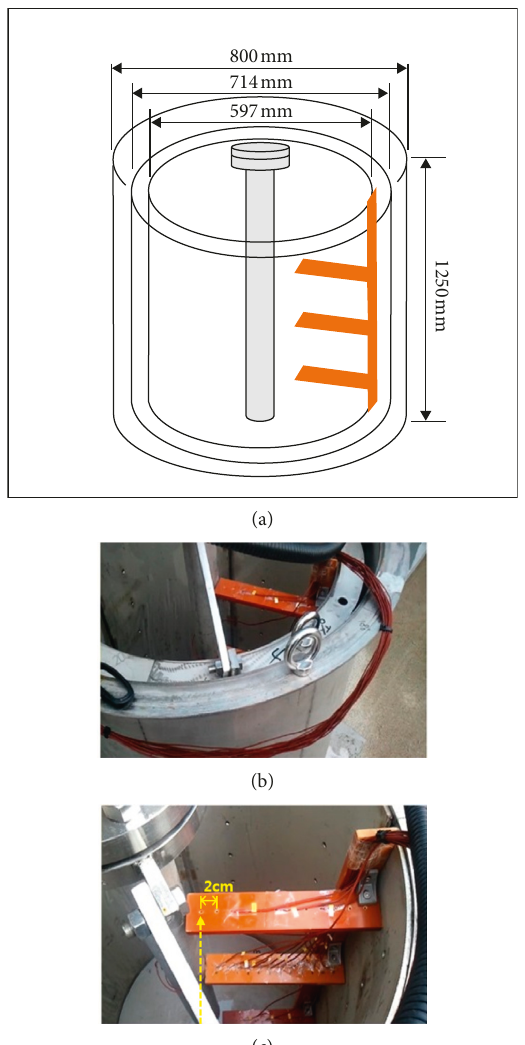
Figure 2: Installation of temperature sensors. (a) Schematic dia- gram of freezing chamber, (b) installed temperature sensor, and (c) temperature sensors on jigs.